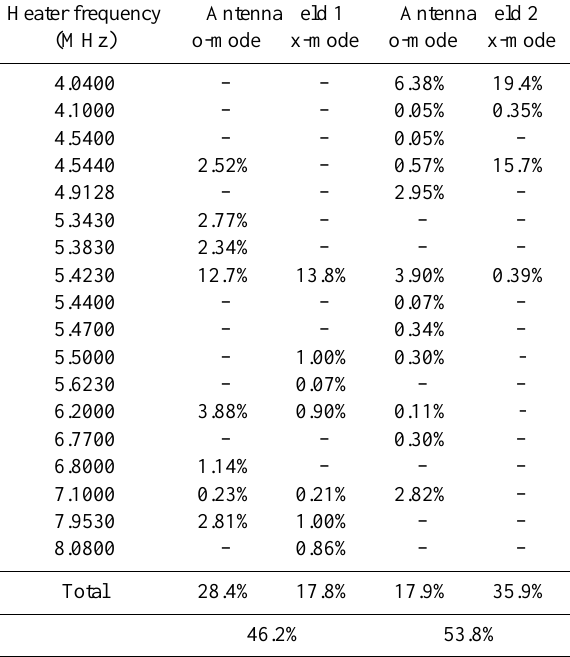
Fig. 6. Dates of selected IRIS data 1994–2004.